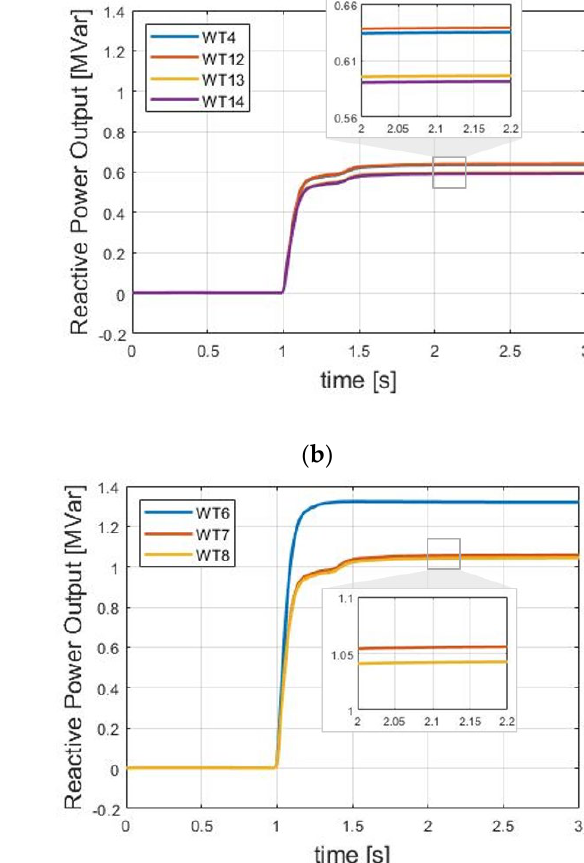
Figure 7. Simulation results: ( a ) Real/reactive power Flow; ( b ) Voltage at PCC.